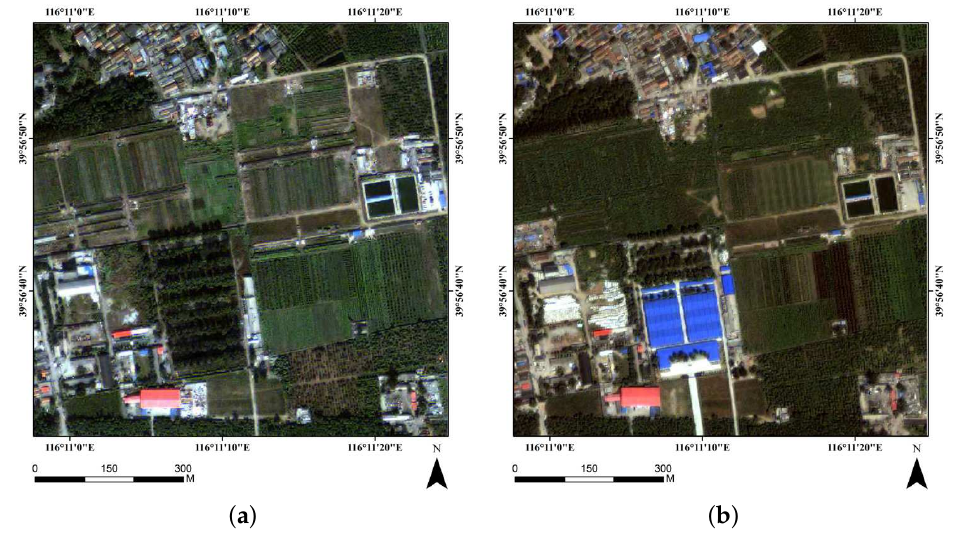
Figure 7. QuickBird data sets. The size of Quickbird is 950 × 950 pixels with 0.6 m spatial resolution. ( a ) Shijingshan, QuickBird, 11 October 2008; ( b ) Shijingshan, QuickBird, 13 September